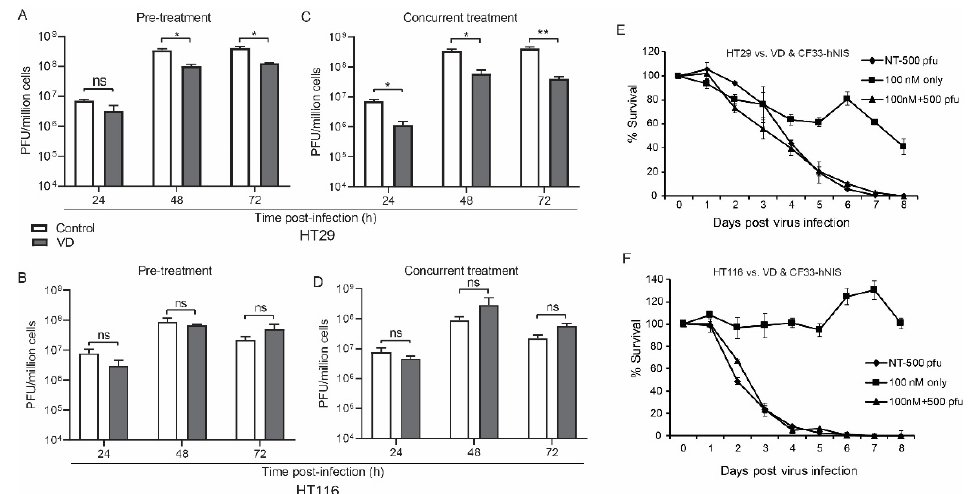
Figure 1. Vitamin D (VD) analogue does not directly affect viral replication. Human colon cancer cells HT29 ( A ) and HCT116 ( B ) were pre-treated with VD or phosphate buffered saline (PBS) for 12 and 14 days respectively and then infected with CF33-hNIS at a multiplicity of infection (MOI) of 0.01 and analyzed daily for 3 days via standard viral plaque assay. Abrogated viral replication in VD-responsive HT29 cells ( C ) versus non-responsive HCT116 cells ( D ) is still more pronounced when cells were concurrently treated and that treatment was continued after viral infection. Cytotoxicity assays over extended period of time with 6 days of VD pre-treatment followed by virus infection alone at a standardized dose rather than MOI are shown for HT29 ( E ) and HCT116 ( F ) cells. Stat = non-paired t -test, * p < 0.05, ** p < 0.01, error bars = standard deviation, ns = non-significant.